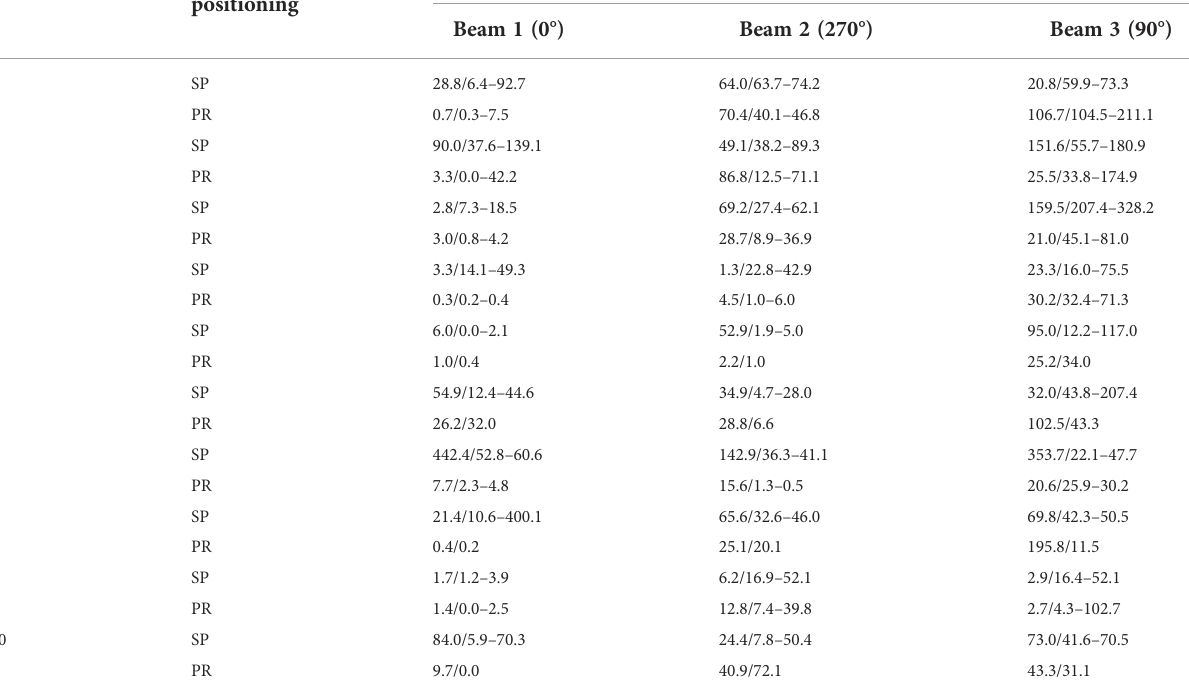
TABLE 4 Gastrointestinal gas volume considering the beam range in beam path (Gas R